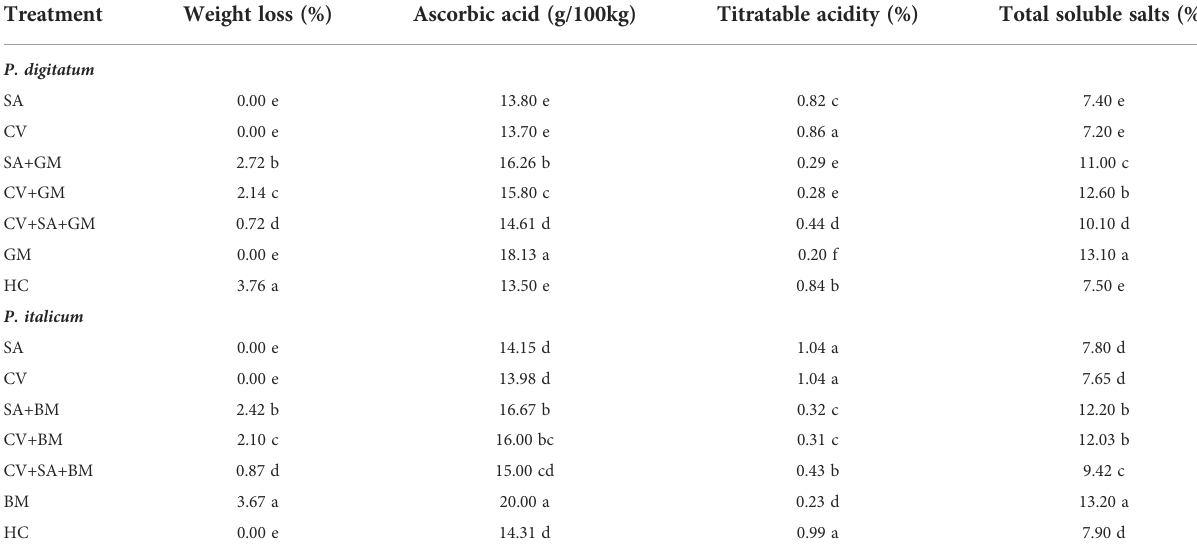
TABLE 3 Post-harvest quality of sweet oranges in response to treatment with SA and cinnamon.